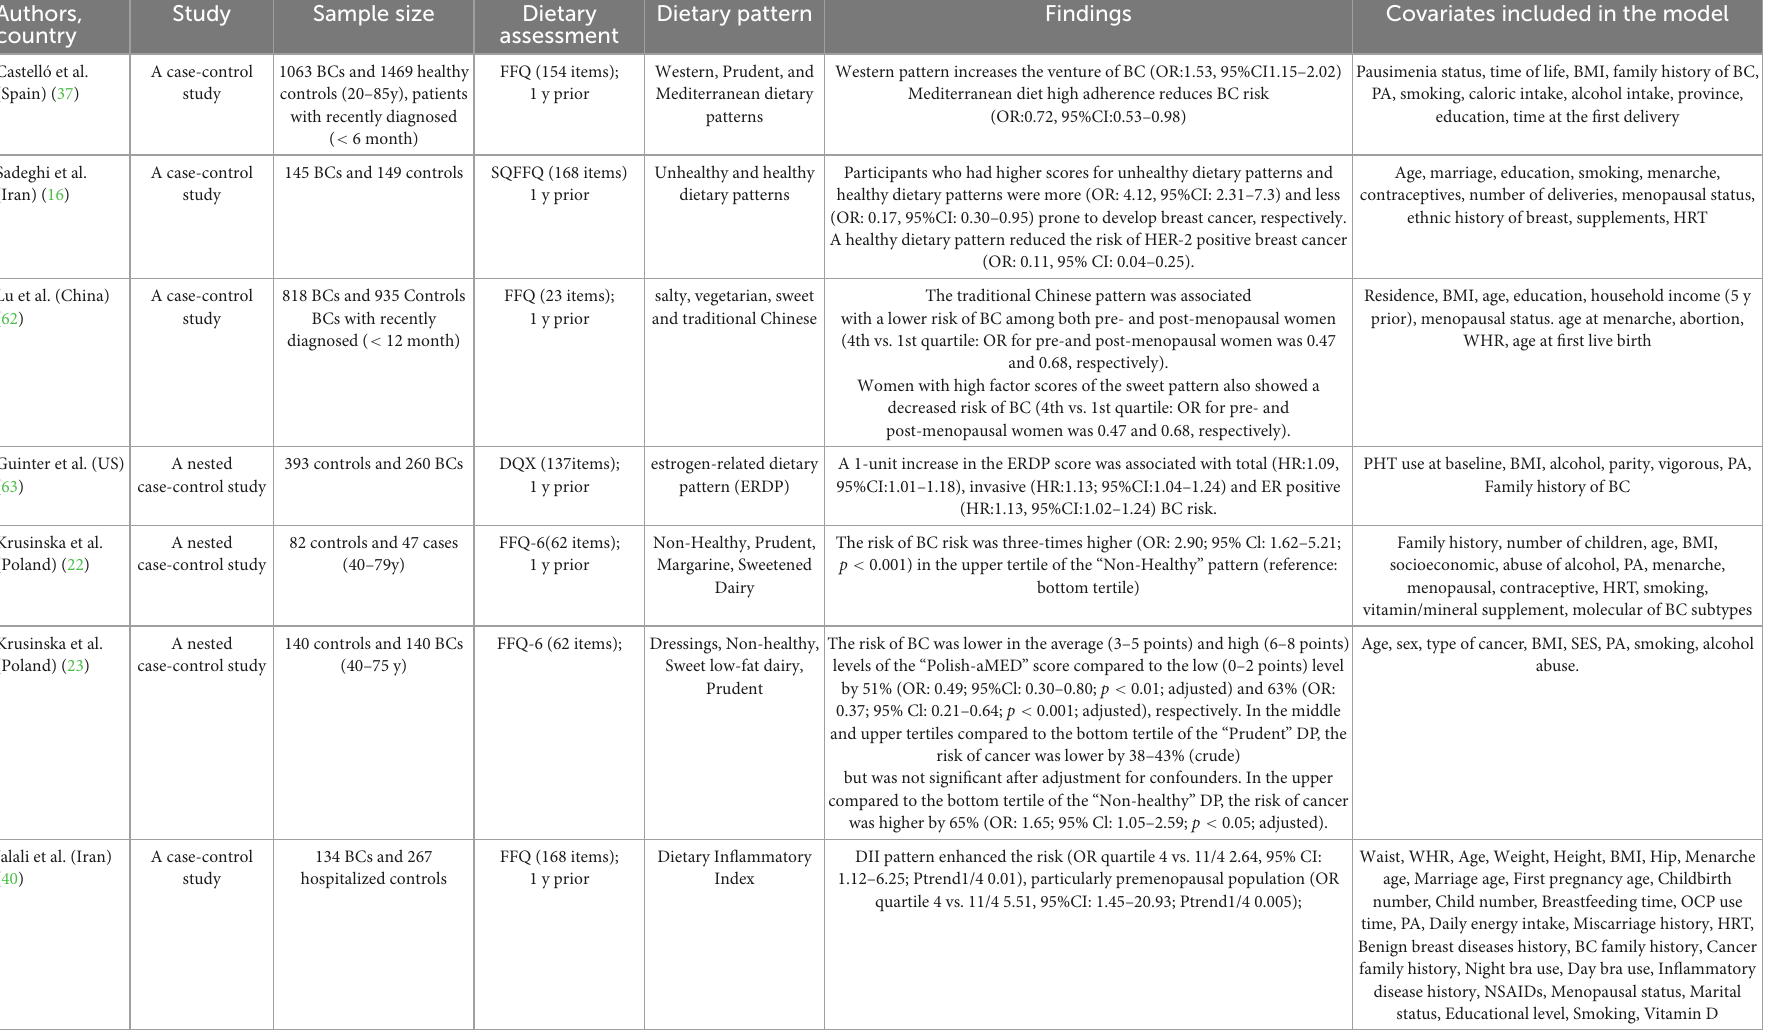
TABLE 1 Dietary patterns: Disease risk, prognosis, and survival